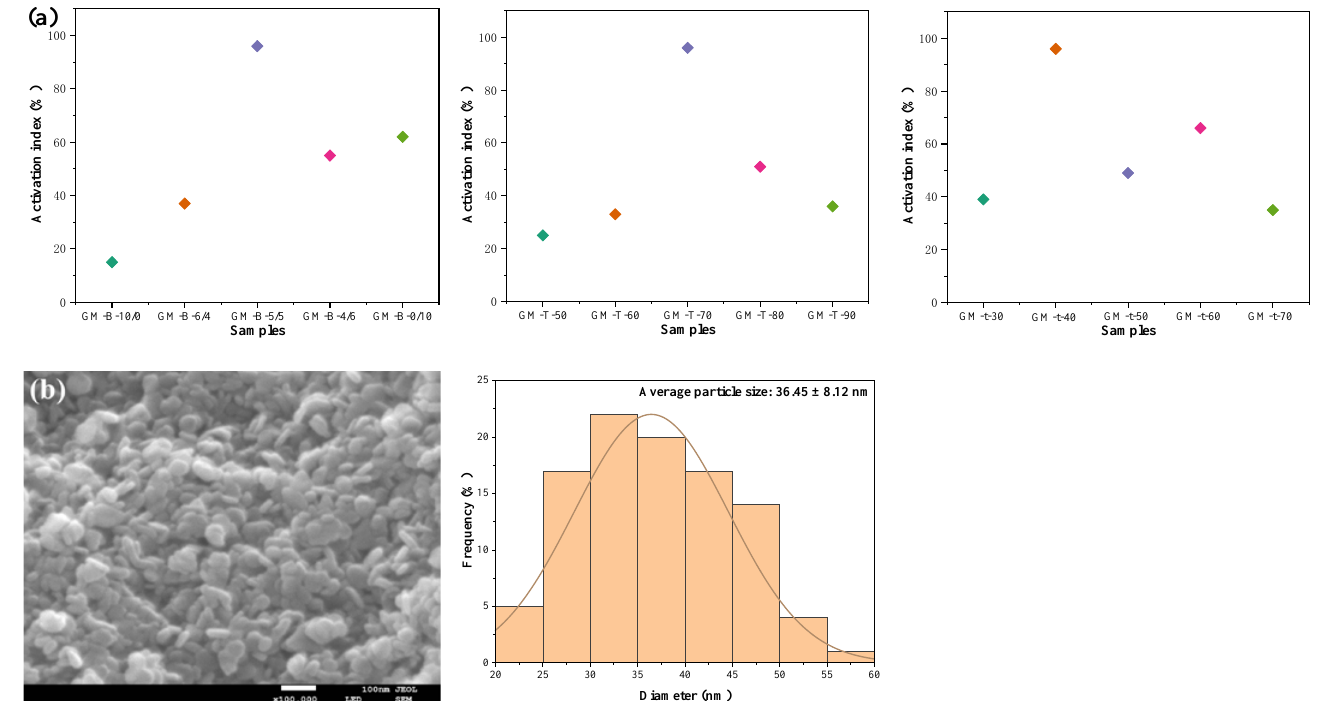
Figure 4. The ( a ) activation index of the modified powders and ( b ) SEM image and particle size distribution of GM-B-5/5.